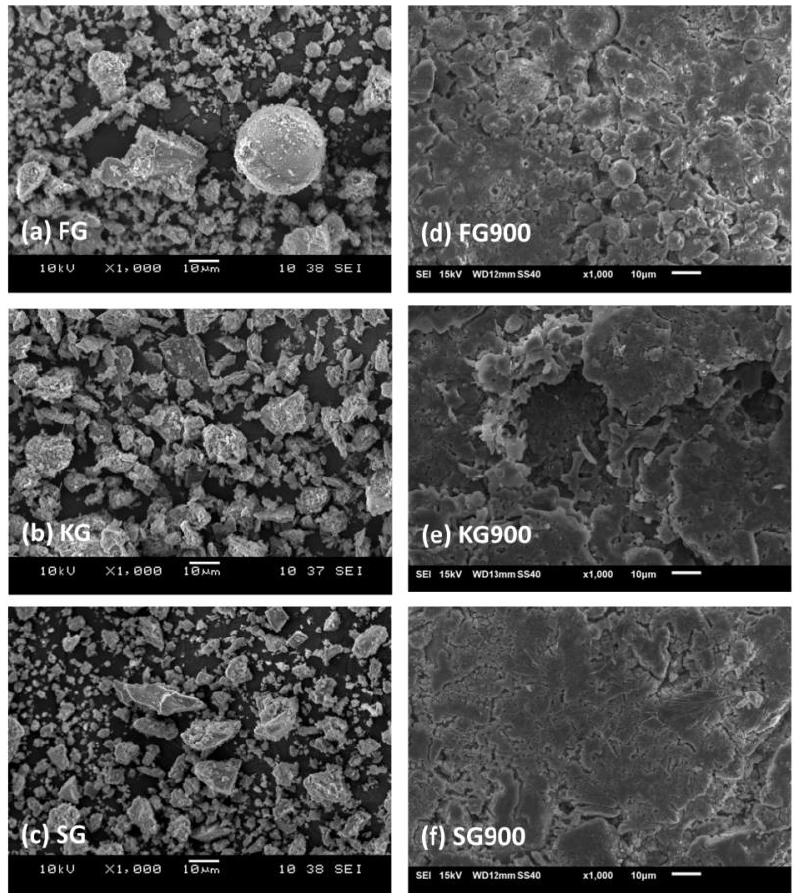
Figure 2. SEM micrograph of the unsintered ( a ) Fly ash geopolymer ( b ) Kaolin geopolymer ( c ) Slag geopolymer and sintered geopolymer at 900 °C ( d ) Sintered Fly ash geopolymer ( e ) Sintered Kaolin geopolymer ( f ) Sintered Slag geopolymer.